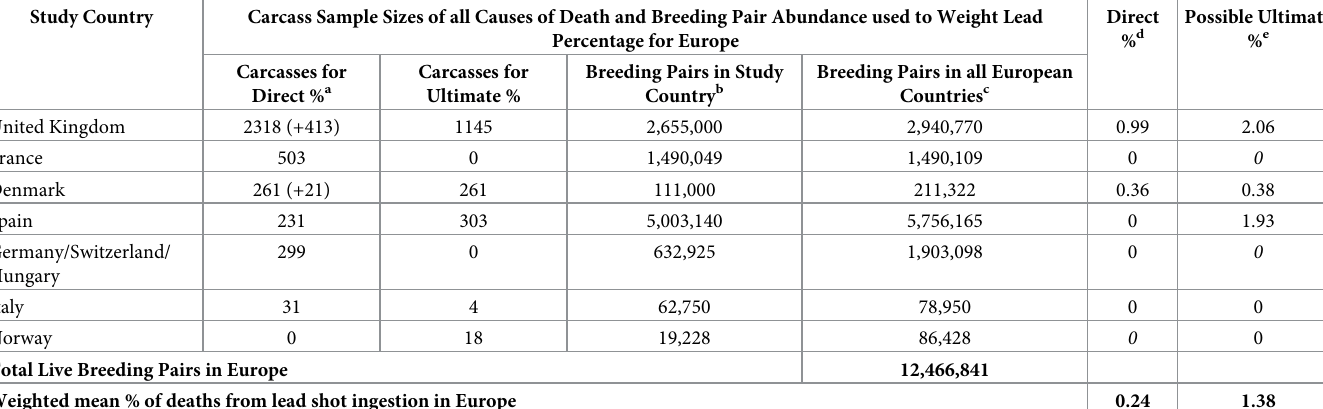
Table 1. Gallinaceous bird carcasses (%) that died directly or ultimately of lead shot poisoning by country and across Europe. Study Country Carcass Sample Sizes of all Causes of Death and Breeding Pair Abundance used to Weight Lead Percentage for